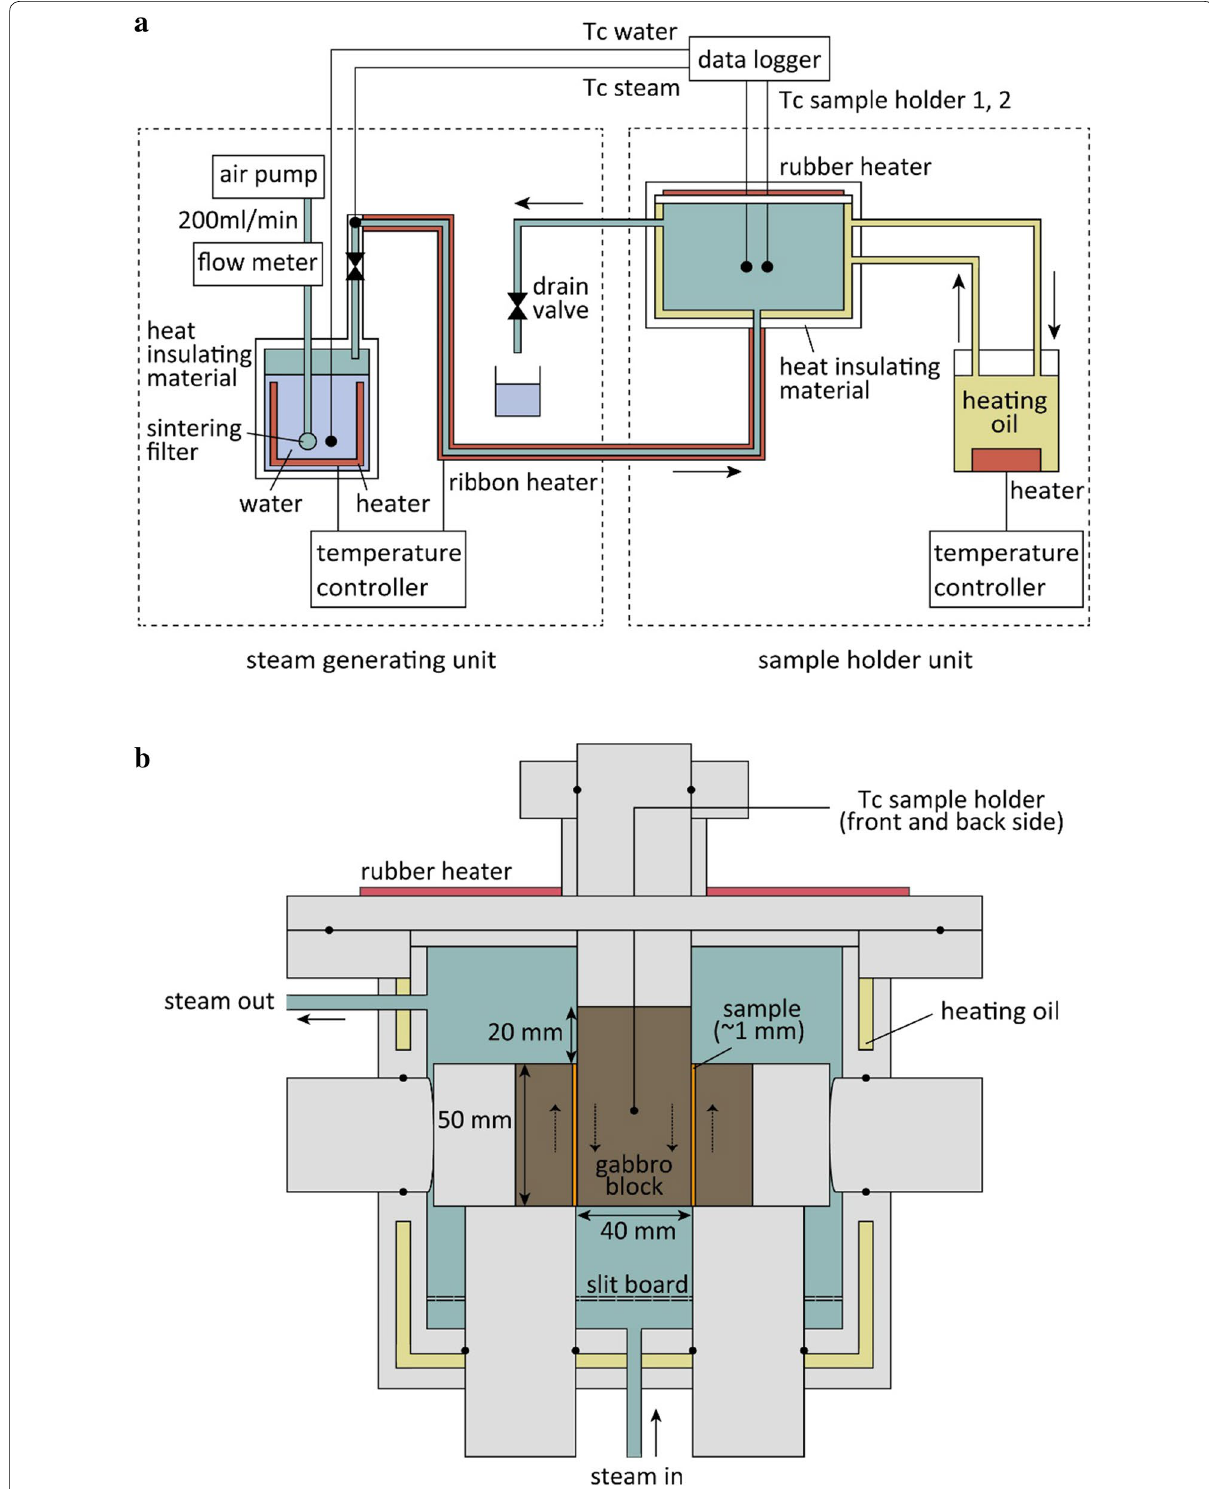
Fig. 2 a Schematic representation of the humidity control system. The relative humidity was controlled by the temperature at the sample holder and steam generator. b Schematic representation of the sample setting in the frictional testing machine. The sample holder was heated with an oil and rubber heater, and the temperature of the sample holder was held constant. The horizontal ram applied a constant normal force and the verti- cal ram applied a shear force at a constant loading velocity. The thermocouple was placed central to the frictional